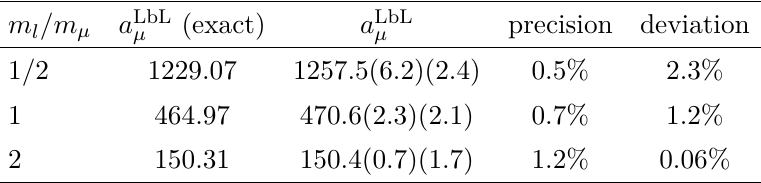
Table 3 . Results, precision and deviation of the lepton-loop contribution to a LbL 10 − 11 ) computed in the continuum with kernel L (0) compared to the known results [81, 82].